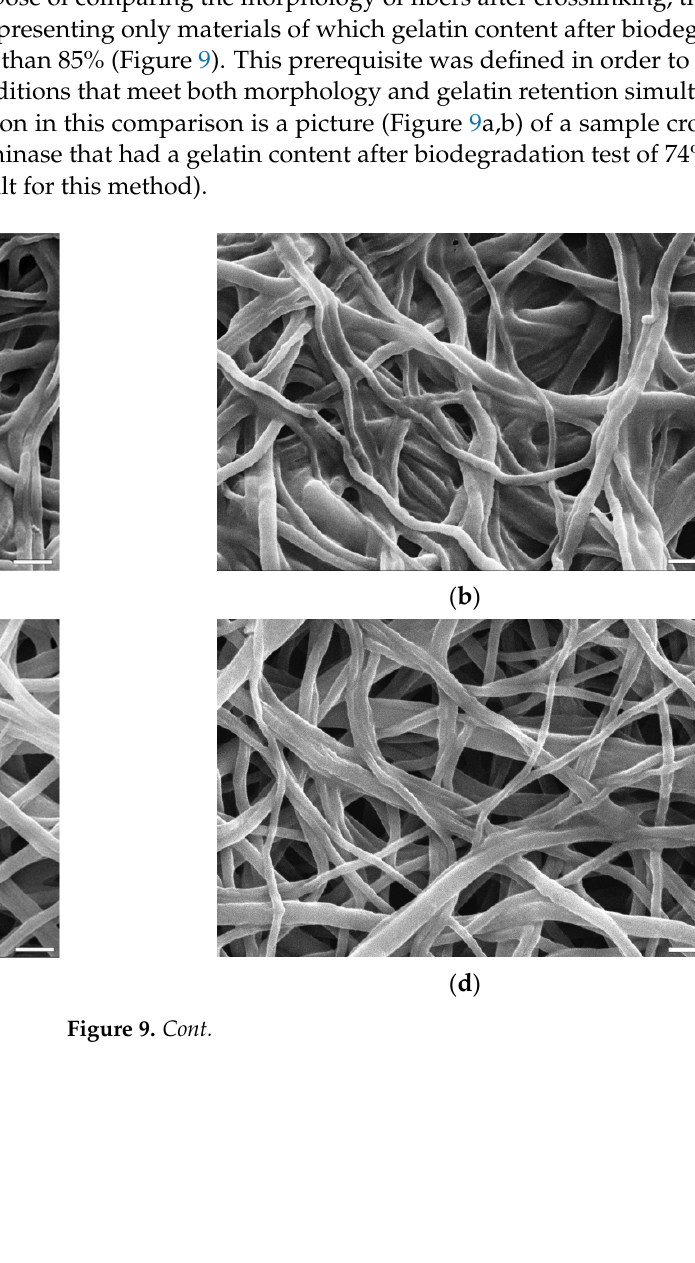
( h ) Figure 9. SEM images of samples crosslinked with different methods: before (left) and after (right) 24 h of biodegradation test: ( a , b ) transglutaminase 40 U/mL, 24 h, ( c , d ) genipin 4%, 48 h, ( e , f ) EDC/NHS 0.12%/0.04%, 40 min, ( g , h ) BDDGE 10%, 48 h. The marker equals 10 µm. Figure 9 presents SEM images of samples’ morphology after crosslinking with all four compounds and after biodegradation test. The differences between these pairs of